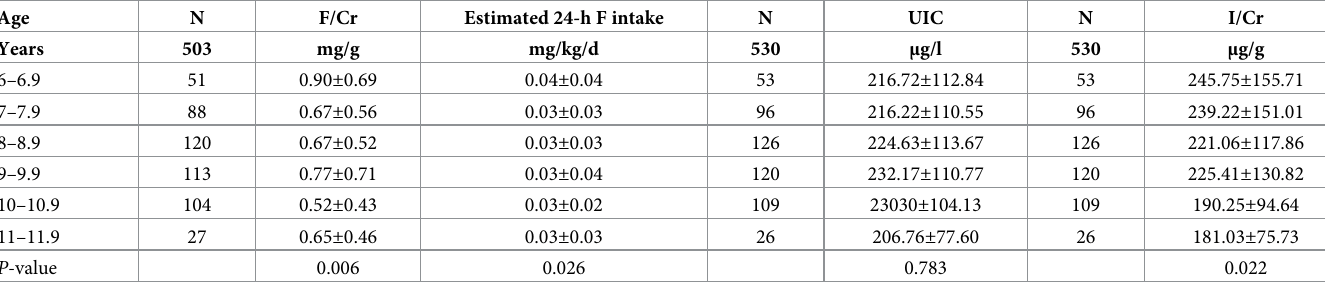
Table 5. Fluoride and Iodine statuses among elementary Emirati schoolchildren of varied age